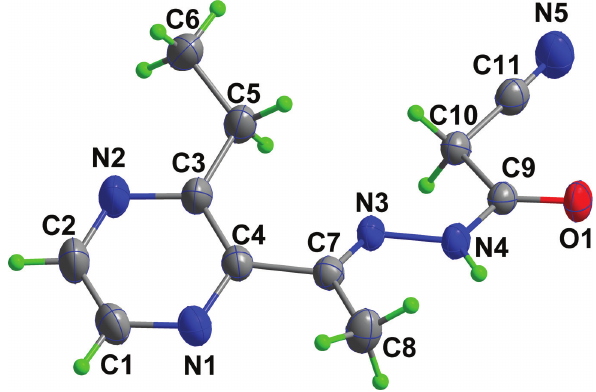
Table 2: Fractional atomic coordinates and isotropic or equivalent isotropic displacement parameters (Å 2